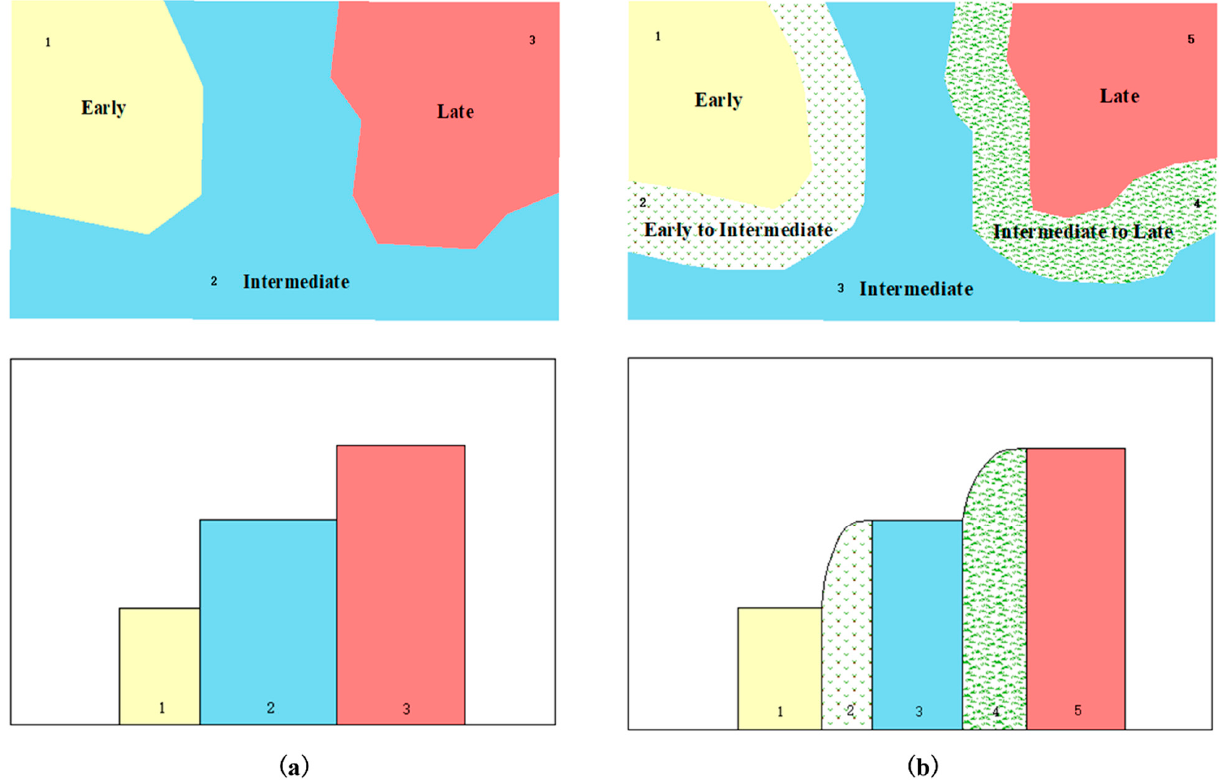
Figure 1. The traditional and refined principles for mapping secondary TDF succession. ( a ) Tradi- tional definitions assume that different successional stages (1, 2 and 3) have deterministic extents. ( b ) Approaches considering the presence of transitions (such as 2 and 4) between the principal successional stages 1, 3 and 5.